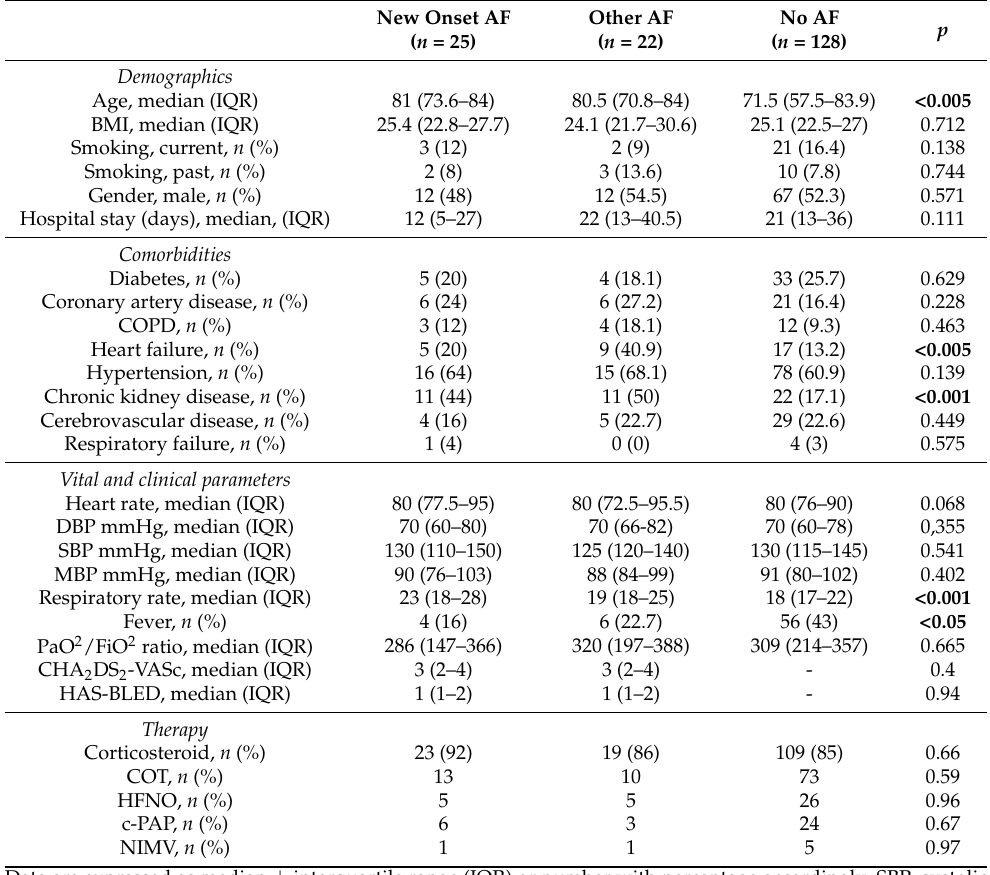
Table 1. Demographic and clinical features of study population at admission.